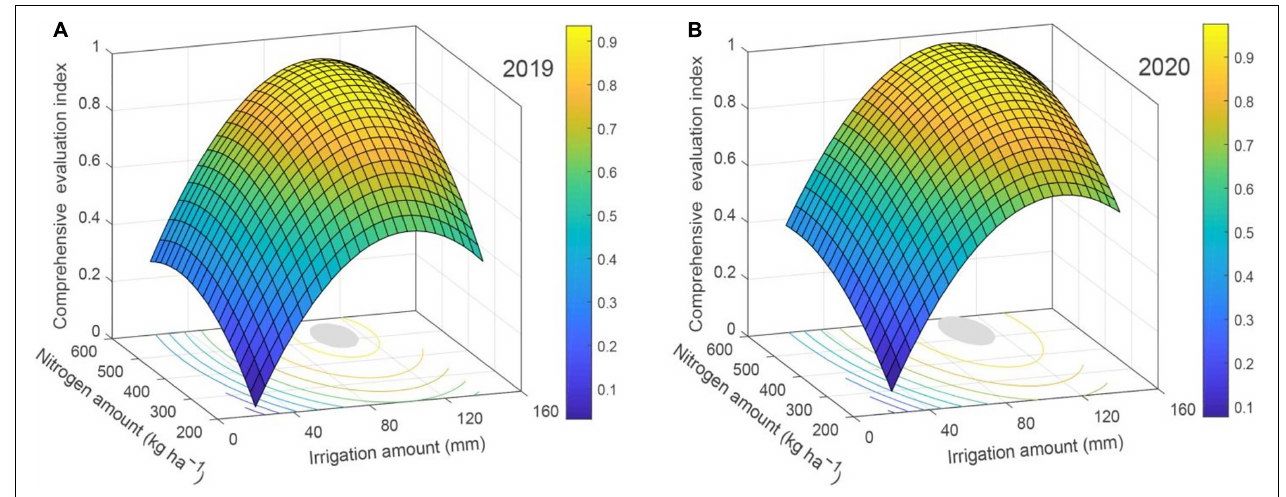
FIGURE 6 | Coupling effects of water and nitrogen on comprehensive evaluation index of mountain apple in 2019 (A) and 2020 (B) .